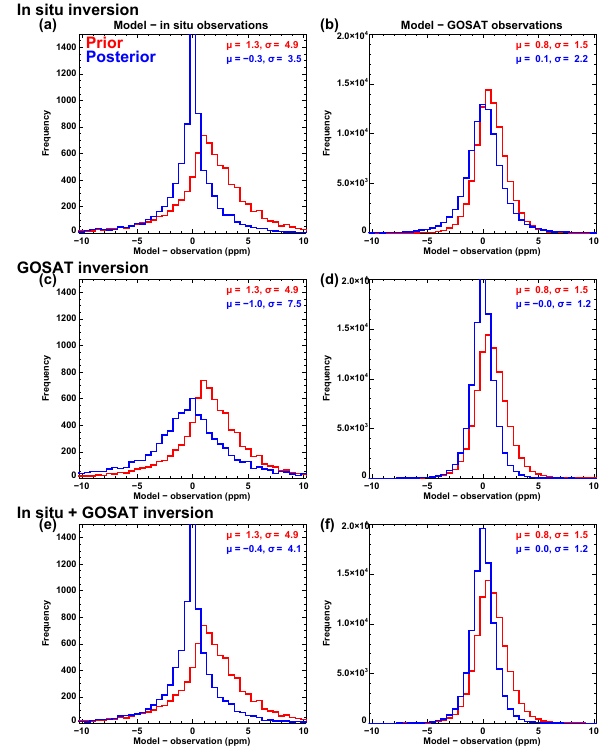
Figure 3. Full comparison of model and observations. Model- observation difference histograms are shown for (a) in situ only inversion and in situ observations, (b) in situ only inversion and GOSAT observations, (c) GOSAT only inversion and in situ ob- servations, (d) GOSAT only inversion and GOSAT observations, (e) in situ + GOSAT inversion and in situ observations, and (f) in situ + GOSAT inversion and GOSAT observations. Mean differ- ences and standard deviations are indicated in the